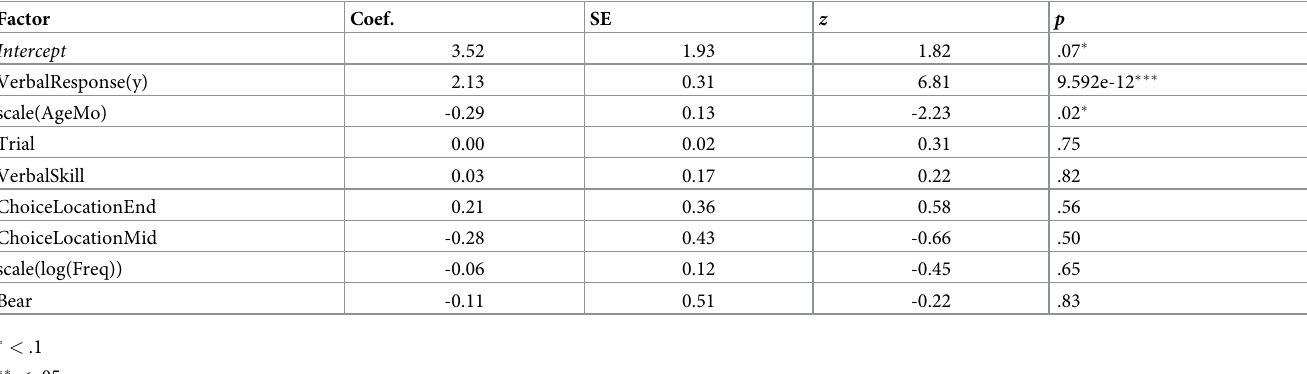
Table 1. Experiment 1 generalized linear mixed effect model results. Factor